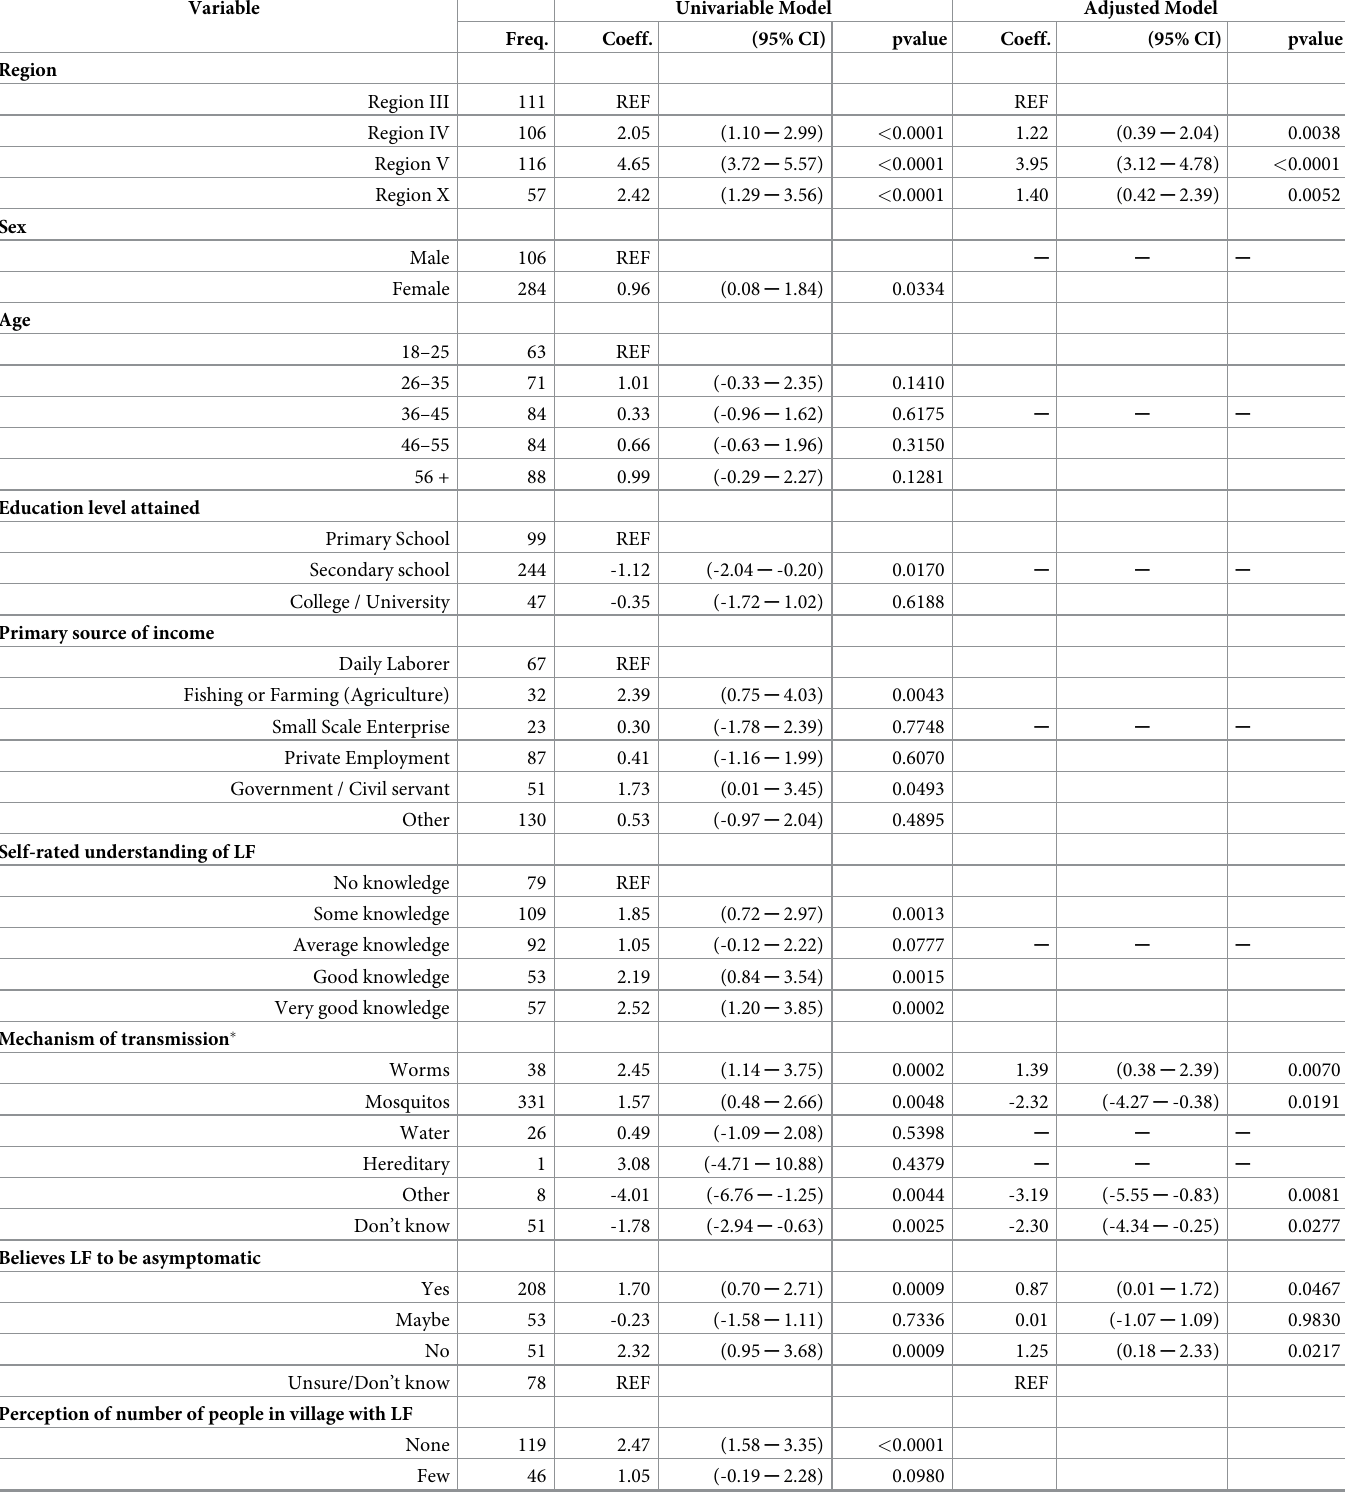
Table 2. Univariable and adjusted linear regression predicting composite acceptability score in the primary study